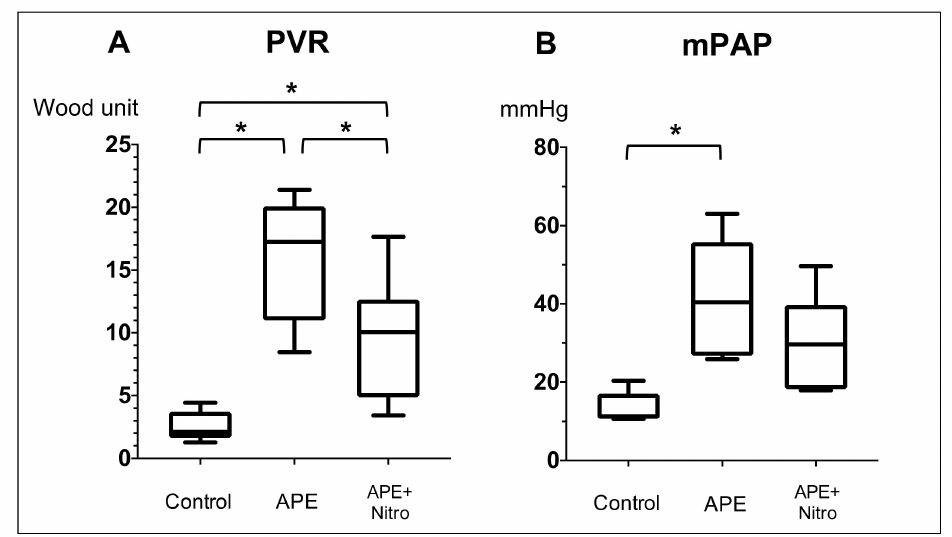
Figure 3. Whisker box plots showing the median (central horizontal line) and interquartile range (25% downward, 75% upward) of the pulmonary vascular resistance (PVR) ( A ) and mean pulmonary artery pressure (mPAP) ( B ) at the baseline (control), after induction of acute pulmonary embolism (APE) and after APE and treatment with nitroprusside (APE + nitro). The upper and lower ends of the whiskers indicate the maximum and minimum values. * p < 0.05.